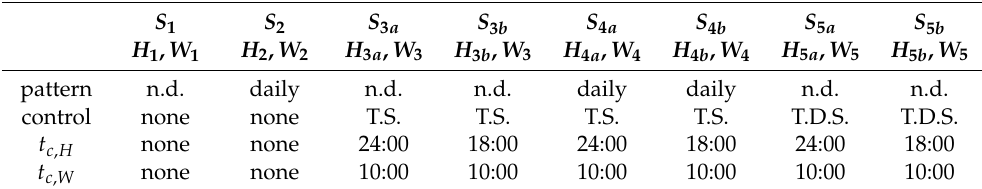
Table 3. Summary of the characteristics of each charging scenario S i , including sub-scenarios a and b , as well as H i and W i . The non-daily (n.d.) charging demand δε is defined as the required energy according to the steady-state model, whereas the daily demand is δε / d p as introduced in the definition of S i